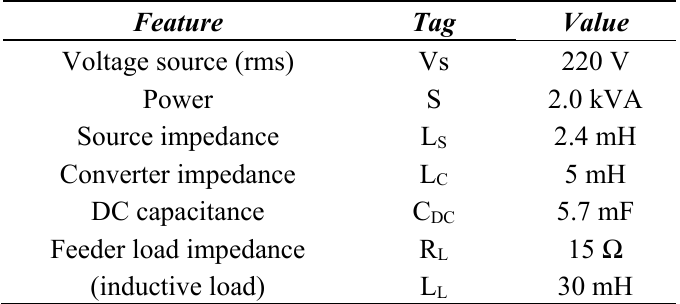
Table 2. Power Circuit Parameters.